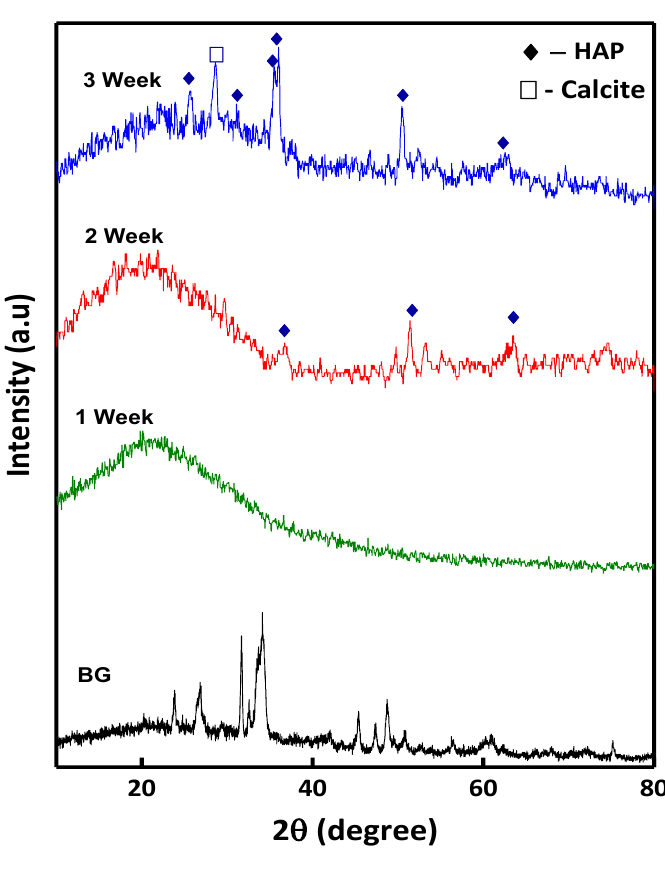
Figure 11. Diffractogram of SBF immersed Bioglass